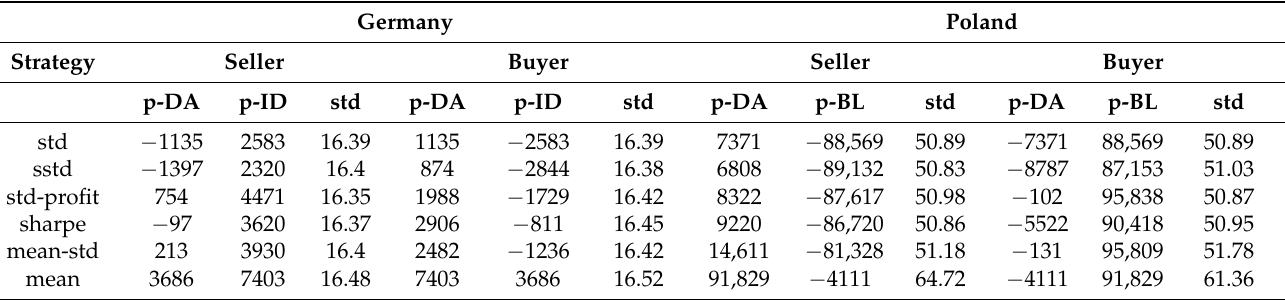
Table 4. Strategy results in the validation window for different objectives for the Polish and German market: total profit over trading only on one of the markets (p-DA for the day-ahead, p-BL for the balancing and p-ID for the intraday market) as well as the portfolio standard deviations (std).